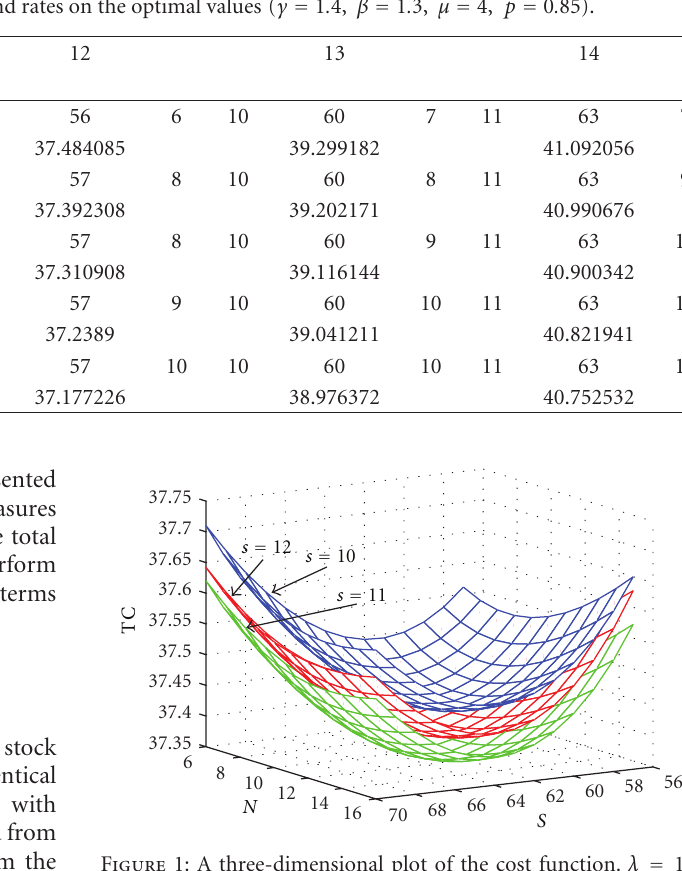
Table 4: E ff ect of primary and postponed demand rates on the optimal values ( γ = 1 . 4, β = 1 . 3, μ = 4, p = 0 . 85).